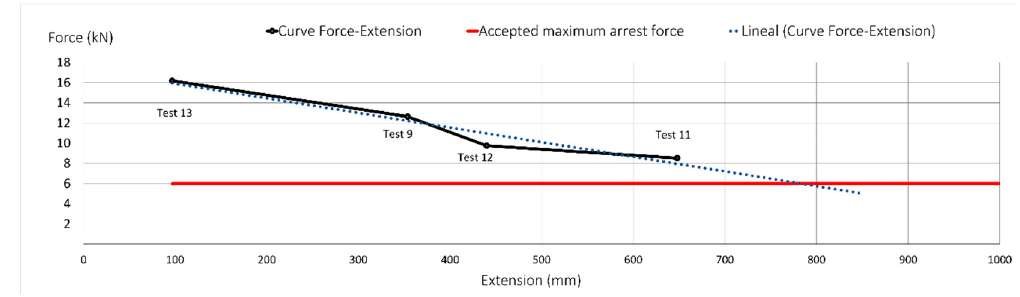
Figure 12. Force-elongation post-test (FF = 2).